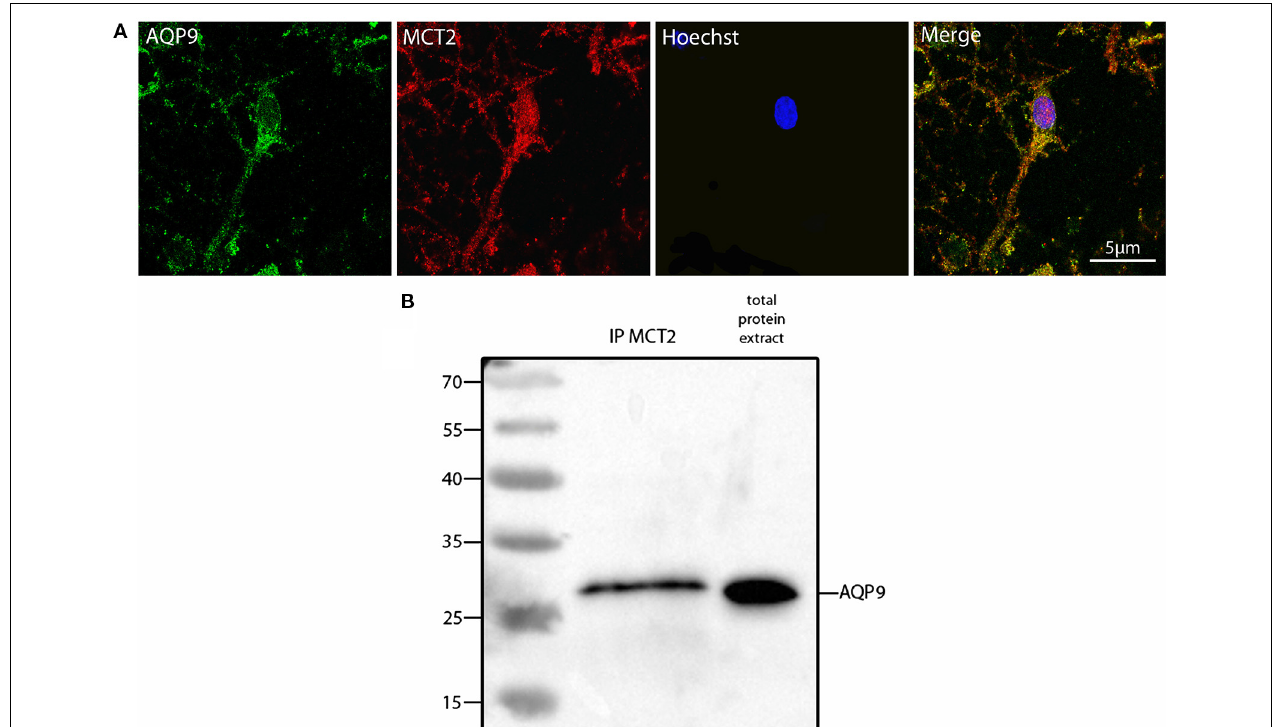
FIGURE 3 | Colocalization and interaction between AQP9 and MCT2 in cultured rat hippocampal neurons (A) Double immunofluorescence labeling for AQP9 (in green) and MCT2 (in red) performed in cultured hippocampal neurons. Colocalization between AQP9 and MCT2 appears as yellow on the merged image (Merge). Nuclei (in blue) were labeled using